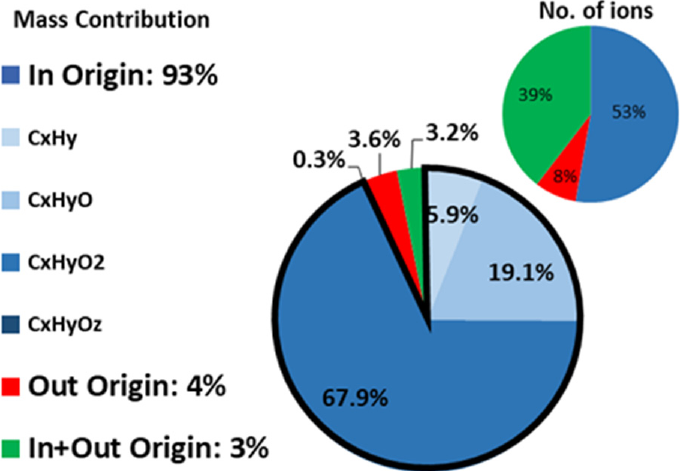
Figure 8. Origin of VOCs (grouped by category) observed indoors in terms of number of ions (small pie) and of mass concentration (large pie).